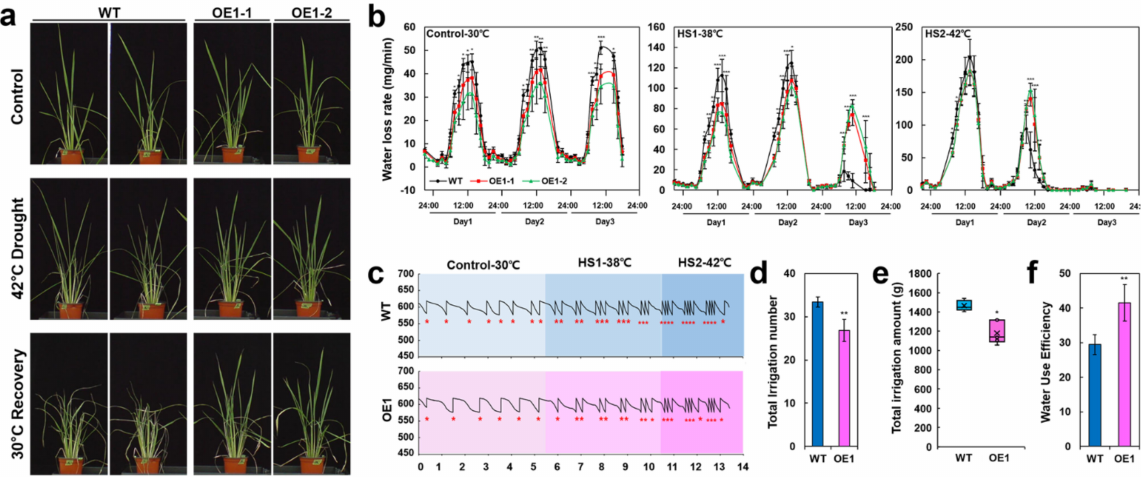
Figure 4. Phenotyping whole plant water use dynamics of OsERF115/AP2EREBP110 -OE transgenic rice using the DroughtSpotter platform under heat-drought combined stress. ( a ) Photographs of OsERF115/AP2EREBP110 -OE and WT plants exposed to the combined stress of drought and heat (42 ◦ C) for 7 days and recovered at 30 ◦ C for 7 days. ( b ) Whole plant water loss rates of OsERF115/AP2EREBP110 -OE and WT plants under NONE mode of DroughtSpotter at three different thermal conditions (Control, HS1, and HS2). Data represent mean ( ± SD) from two independent experiments with five plants of each line. Two-way ANOVA and Fisher’s LSD test were performed by comparing with WT plants as controls (*, p < 0.05; **, p < 0.01; ***, p < 0.001). Asterisks indicate significant differences in OE1-1 and OE1-2 compared to WT at each time point. ( c – e ) Whole plant water use phenotypes of OsERF115/AP2EREBP110 -OE and WT plants under 7% DYNAMIC mode of DroughtSpotter at three different temperature thermal conditions. ( c ) Representative irrigation graphs from soil-pots of OsERF115/AP2EREBP110 -OE and WT plants. ( d ) Total number and ( e ) amount of irrigated water input to soil-pots of OsERF115/AP2EREBP110 -OE and WT plants. Data represent mean ( ± SD) from two independent experiments with 4 plants of each line. One-way ANOVA was performed by comparing with WT plants as controls (**, p < 0.01). ( f ) Whole plant water use efficiency (WP-WUE) of OsERF115/AP2EREBP110 -OE and WT plants. WP-WUE was calculated by the ratio between the plant area gain and total amount of water input throughout the experimental period. Data represent mean ( ± SD) from two independent experiments with four plants of each line. Student’s t -test